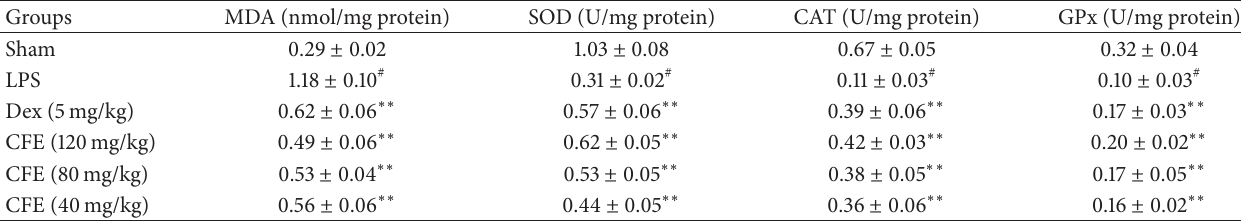
Table 2: The effects of CFE on LPS-induced the levels of MDA, SOD, CAT, and GPx.